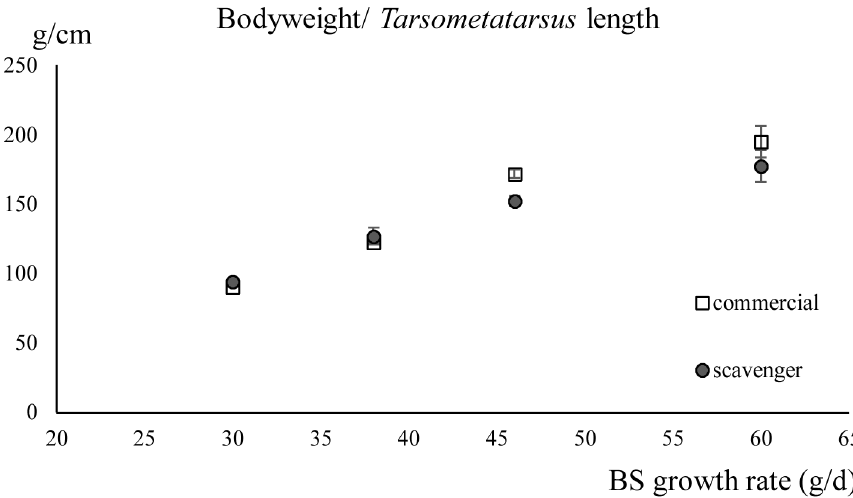
Fig 6. The ratio of bodyweight/ t arsometatarsus length ( ± standard deviation) of chickens fed the scavenger or the commercial diet in function of their breed-specific (BS) growth rates. BS growth rates: 60g/ d (Cobb), 46g/ d (CobbSasso), 38g/ d (Sasso) and 30g/ d